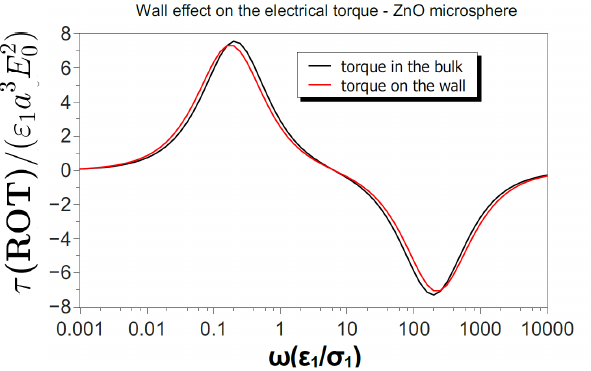
Figure A2. Time-averaged electrical torque (in units of ε 1 a 3 E 2 rotating electric field on a ZnO microsphere (¯ λ D 1 = ¯ λ D 2 = 0.006). The maximum torque for a sphere on the wall is 3.6% smaller than the maximum torque for the sphere in the liquid